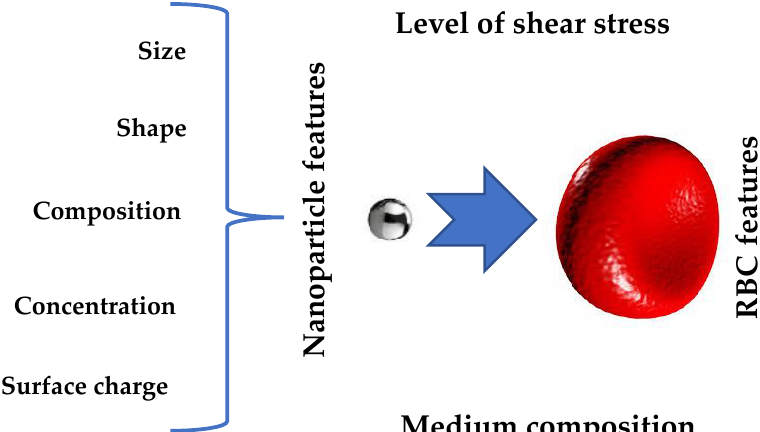
Figure 2. Factors that affect the hemolytic activity of nanoparticles.